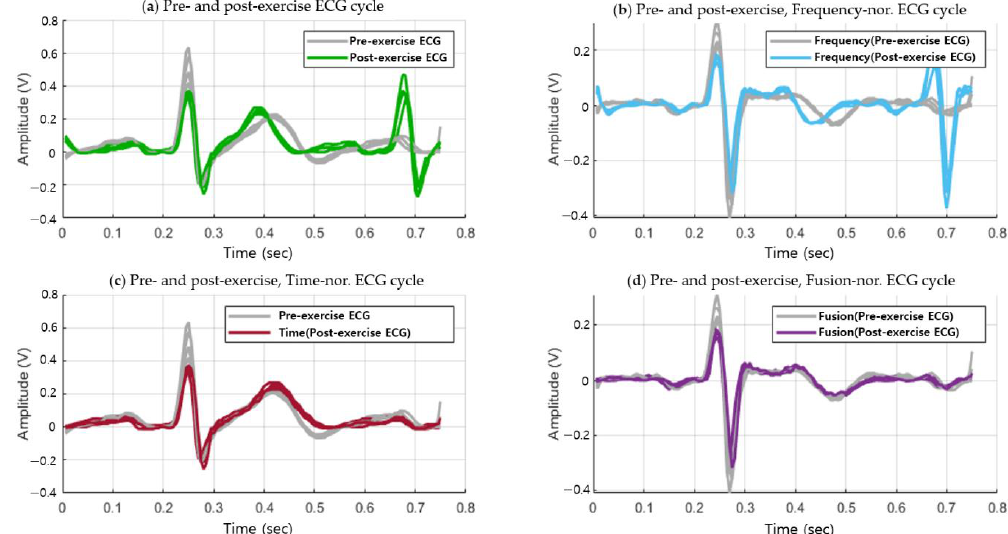
Figure 9d. The existing method analyzed the ECG cycles before and after exercise using the frequency spectrum and normalized them by finding the matching band and applying it in the same manner.